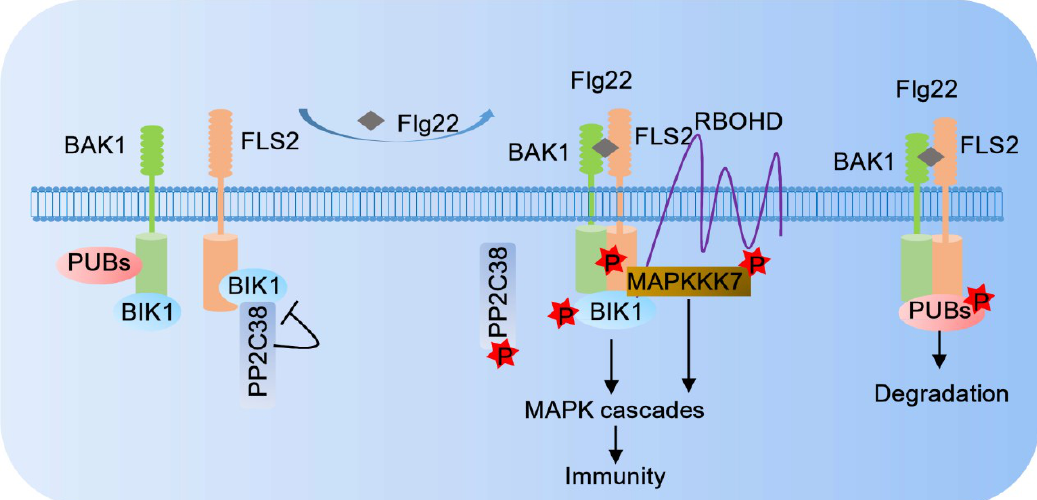
Figure 1. Ligand perception activates FLS2-mediated plant immunity. In the absence of flg22, BIK1 associates separately with FLS2 and BAK1 in an inactive state. Ligand perception induces rapid FLS2–BAK1 receptor complex formation and probably transphosphorylation, which further activates downstream intracellular immunity signaling.